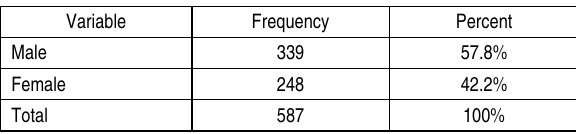
Table 1. Study sample distribution according to